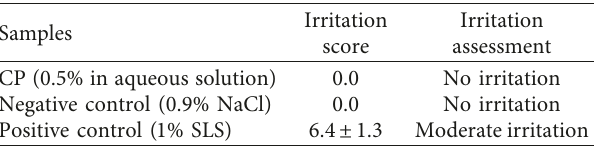
Figure 2: The influence of various concentrations of CP ( 0.10mg/ml, 0.05mg/ml, and 0.01mg/ml), caffeine (CF) ( 0.10mg/ml, 0.05mg/ml, and 0.01mg/ml), and RAW 264.7 cells without LPS (control) and cells induced with LPS (LPS) Different letters mean significant differences ( p < 0 . 05). Table 5: Irritation score and irritation assessment from HET-CAM assay.